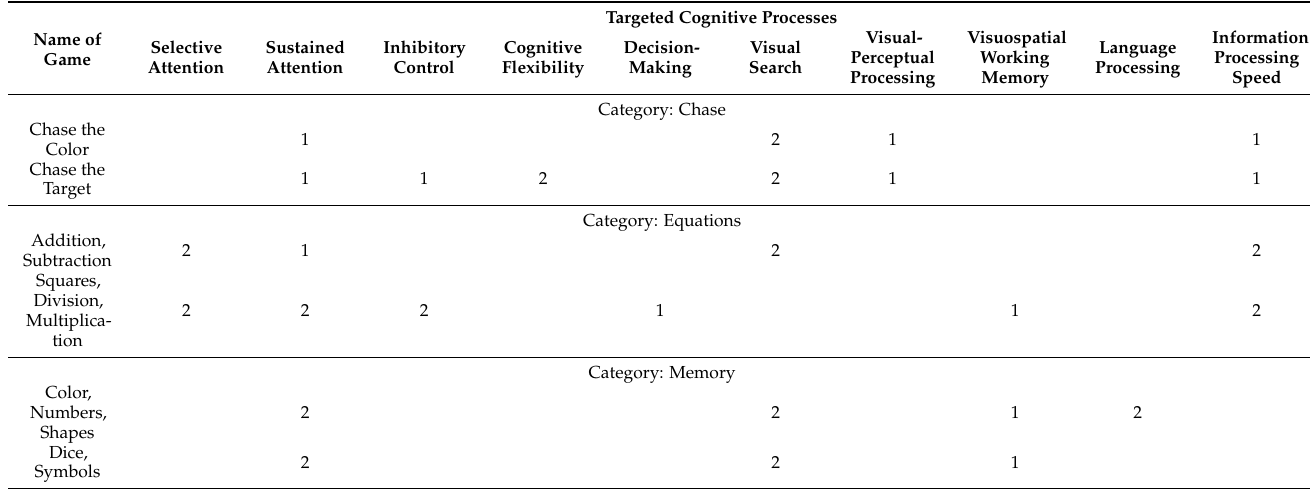
Table A2. List of 16 cognitive tasks from the SMARTfit ® Single system